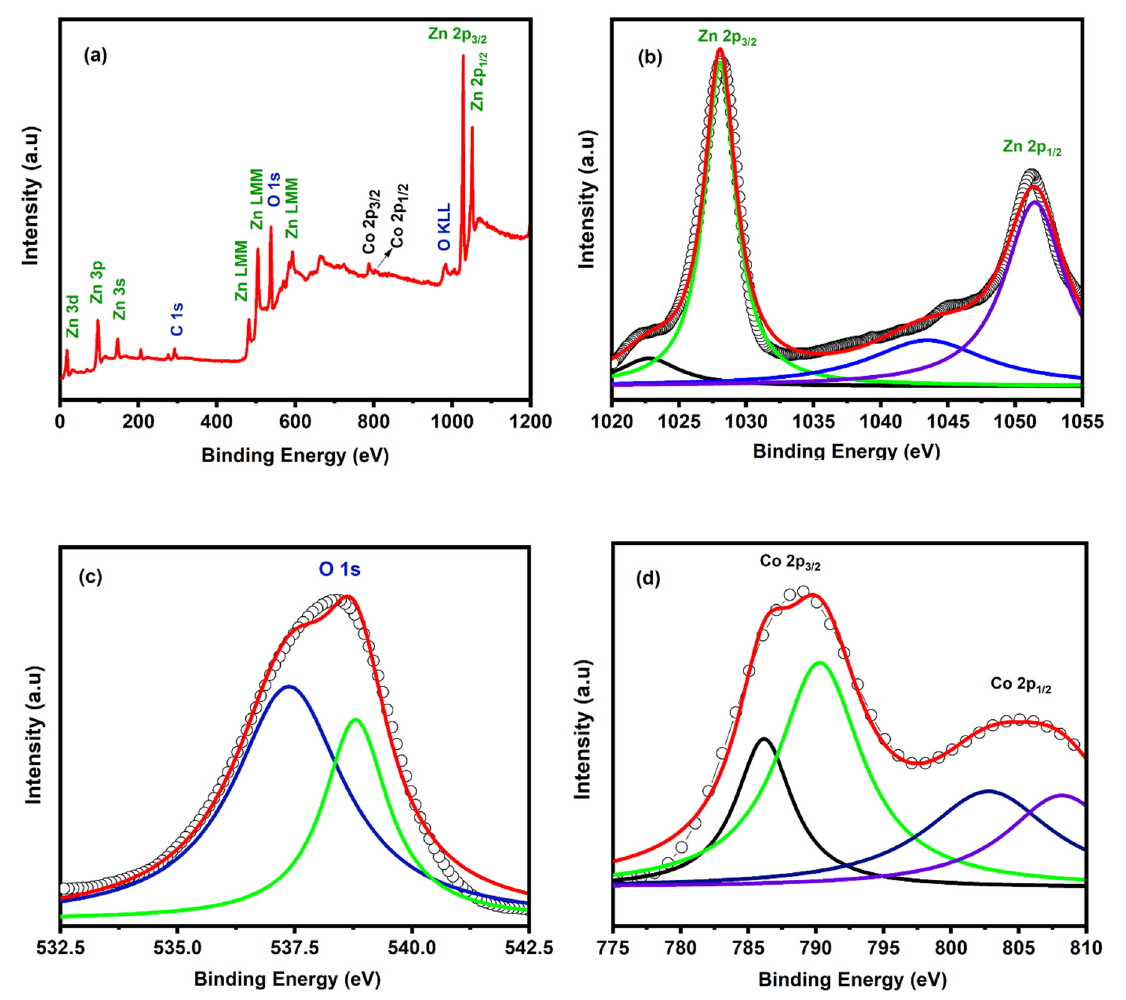
Figure 4. ( a ) XPS survey of Co-doped ZnO microcrystals. ( b ) High resolution XPS spectra of Zn 2p. ( c ) High resolution XPS spectrum of O 1s. ( d ) High resolution XPS spectra of Co 2p.